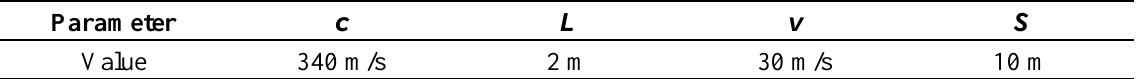
Table 1. Parameters of the simulation Doppler distorted signal.